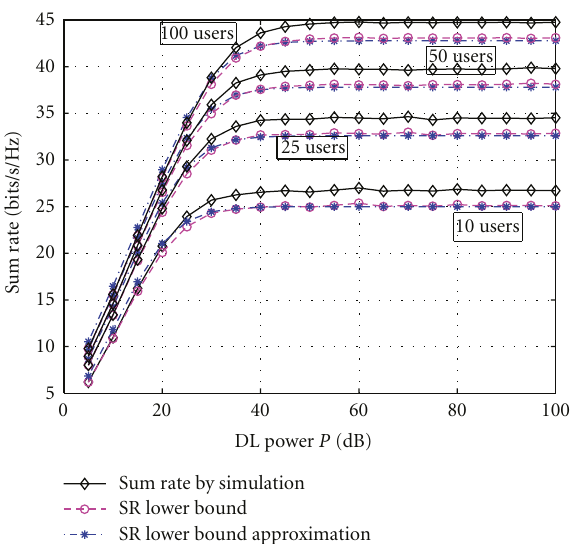
Figure 4: Sum Rate versus number of users feeding back, for various DL powers P